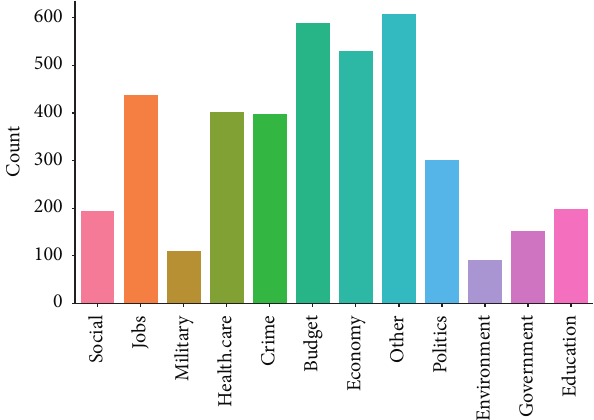
Figure 4: Number of records per category for subject attribute after